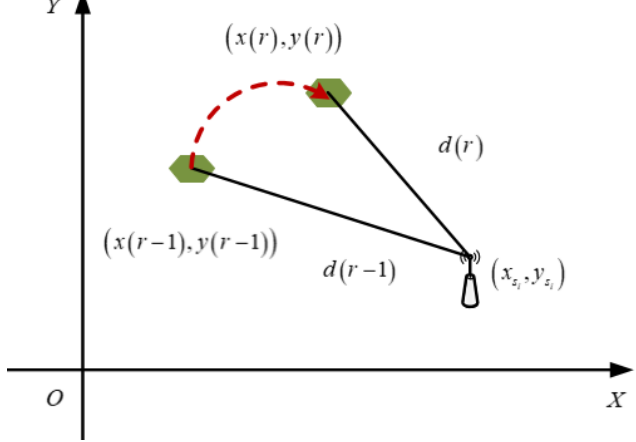
Figure 6. Change of relative